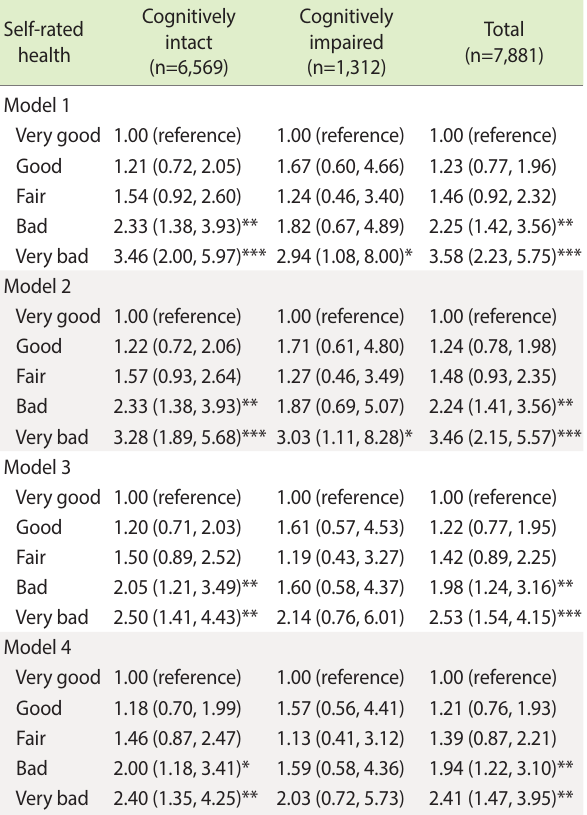
Values are presented as hazard ratio (95% confidence interval). Model 1: adjusted for gender and age; Model 2: adjusted for the vari- ables included in model 1 and additionally those for education and marriage; Model 3: adjusted for the variables included in model 2 and additionally those for the Korean Activities of Daily Living, number of chronic disease, being disabled and having depression; Model 4: ad- justed for the variables included in model 3 and additionally those for smoking status, problematic drinking and regular